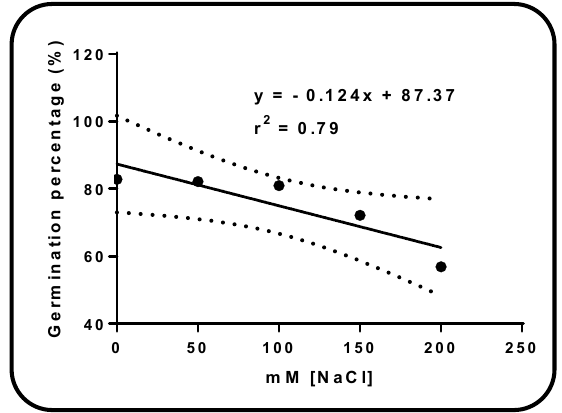
Figure 1: Relationship between germination percentage and salinity (NaCl) in cultivated common bean